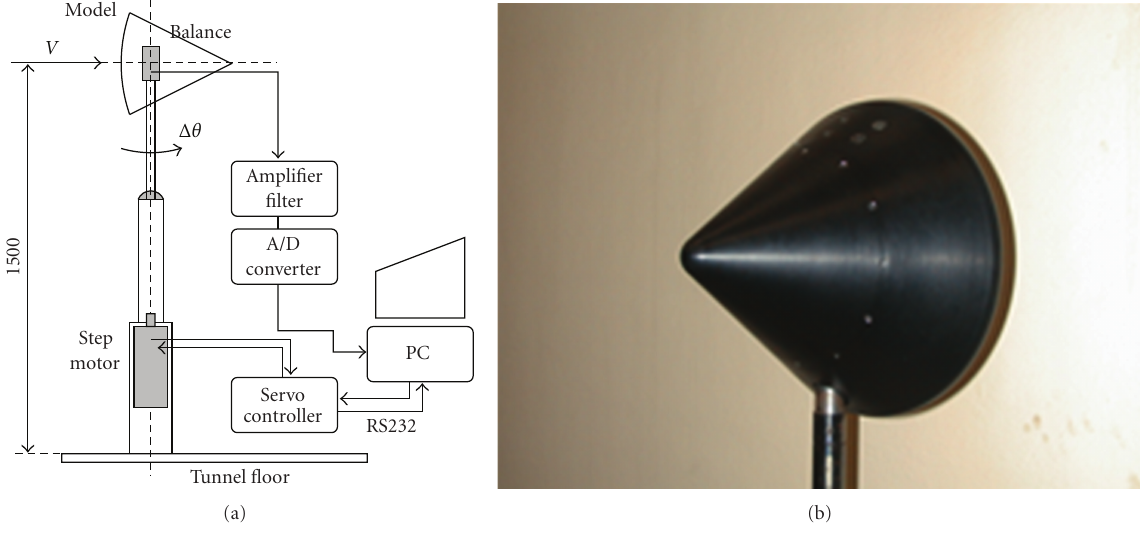
Figure 4: The experimental setup